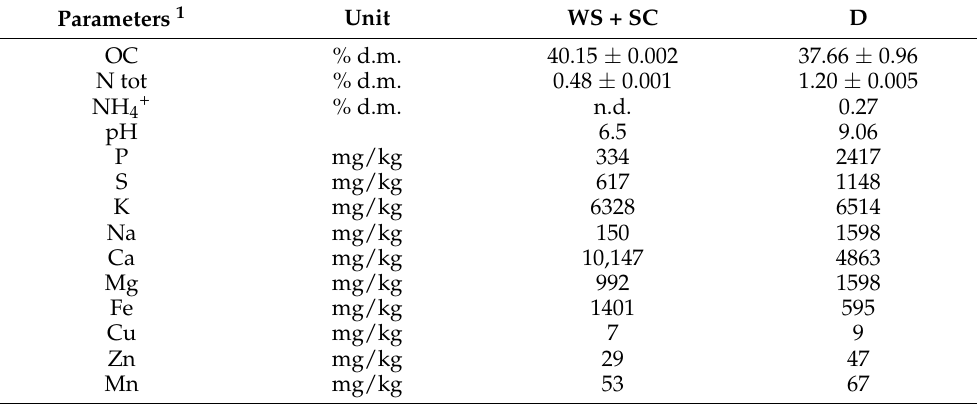
Table 1. Chemical analyses of the conventional substrate (WS + SC) and digestate